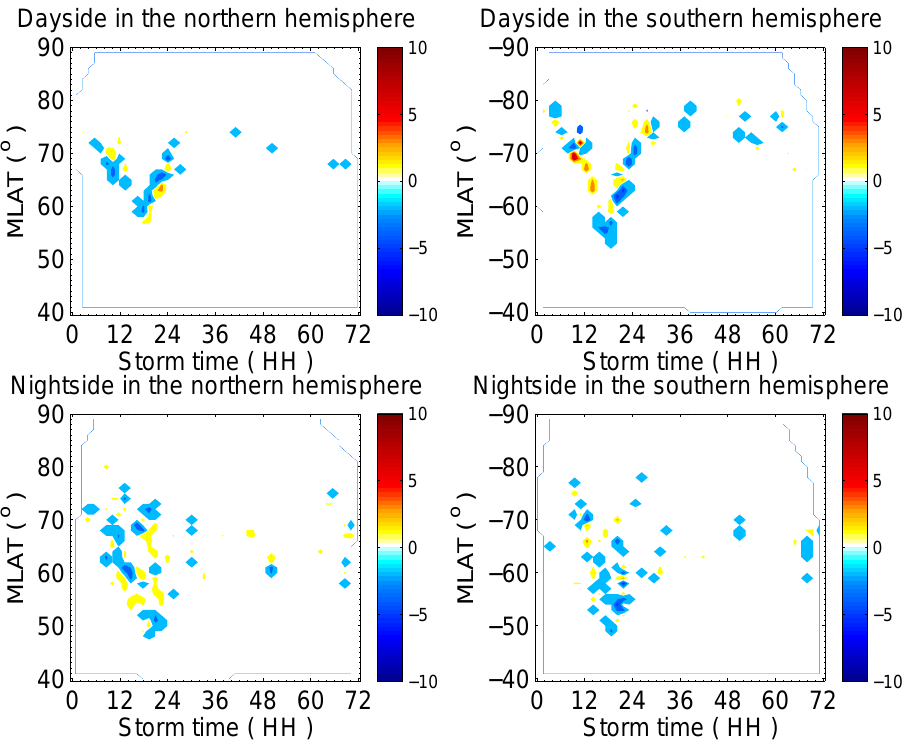
Fig. 7. Storm-time FACs observed by CHAMP in the daytime (top) and nighttime (bottom) sectors on 20–22 November 2003 in the Northern (left) and Southern (right) Hemispheres. Current densities are given in µ A/m 2 .